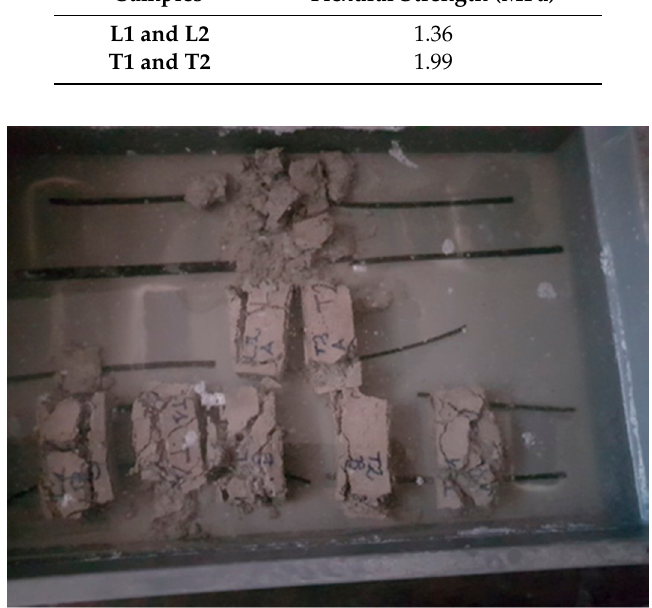
Figure 12. Imbibition of L1, L2, T1 and T2 specimens after salt crystallisation cycle and flexural strength test. Specimens breakdown.